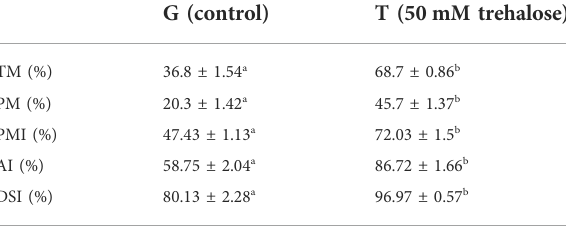
TABLE 1 Effects of 50 mM trehalose addition on sperm characteristics after freeze — thawing. The data are presented as the mean ± SEM; values with different superscripts within a row differ signi fi cantly ( p < 0.01). TM, total motility; PM, progressive motility; PMI, plasma membrane integrity; AI, acrosome integrity; DSI, DNA structural